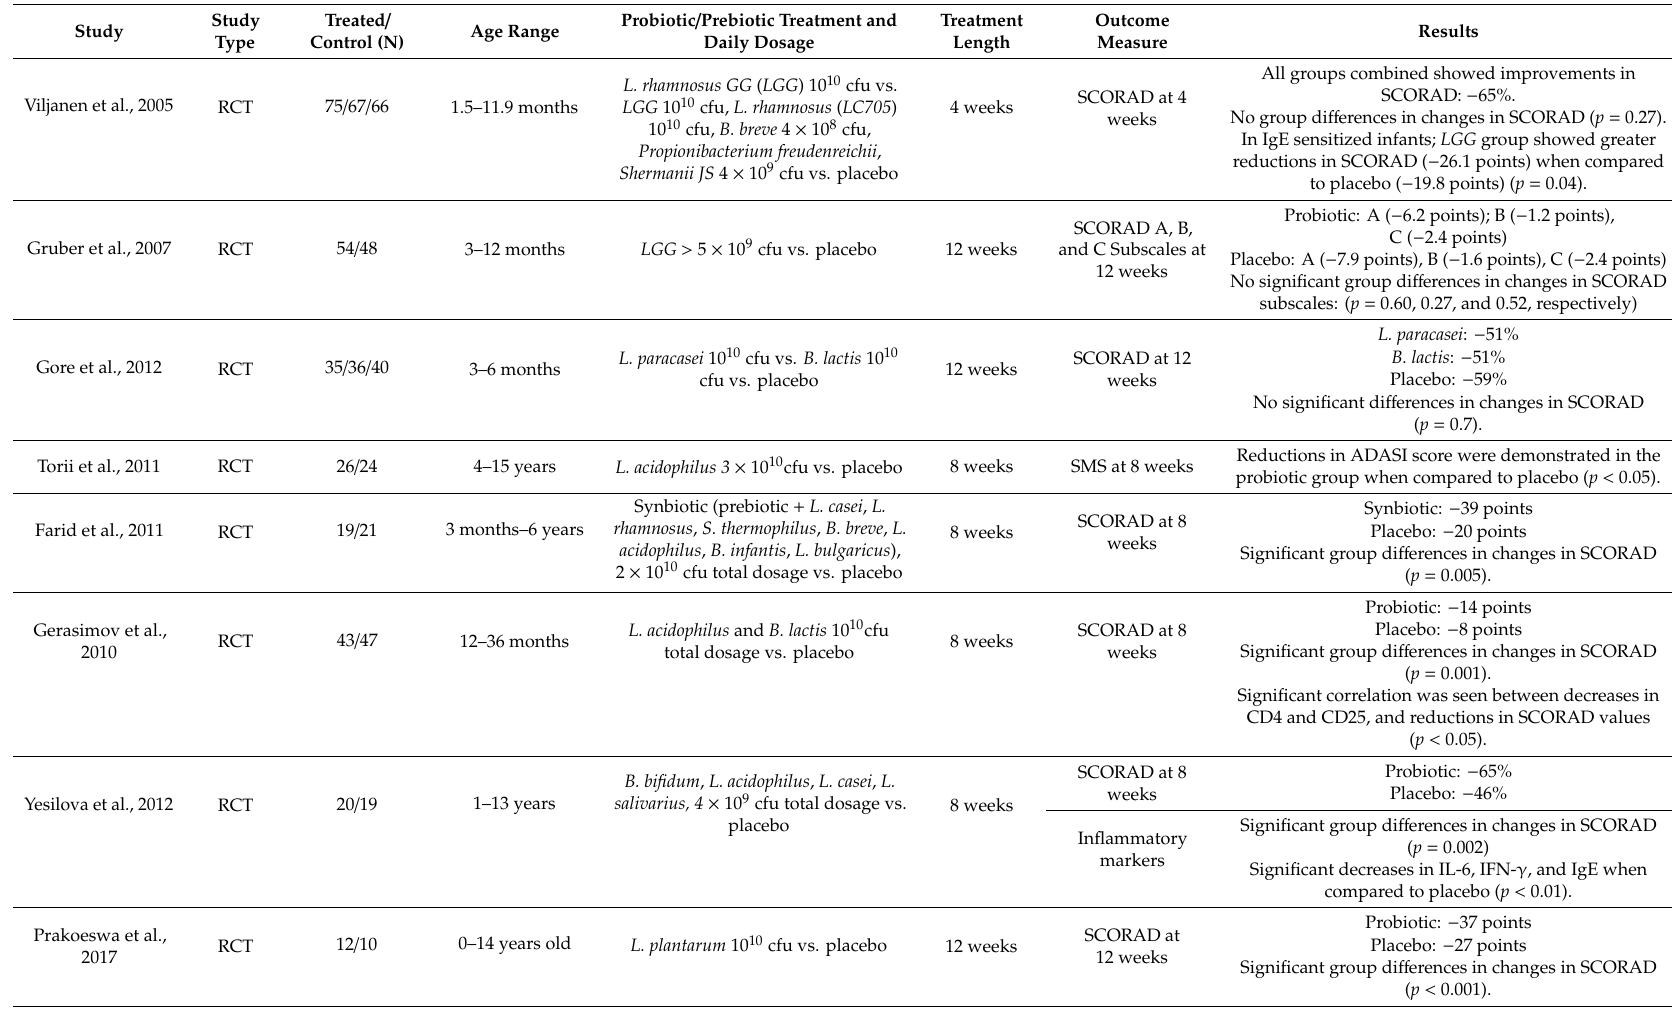
Table 1. Probiotics / prebiotics for the treatment of pediatric atopic